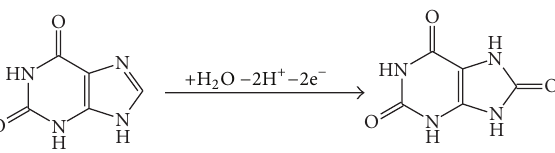
Figure 9: The electrochemical reaction mechanism for Xa.